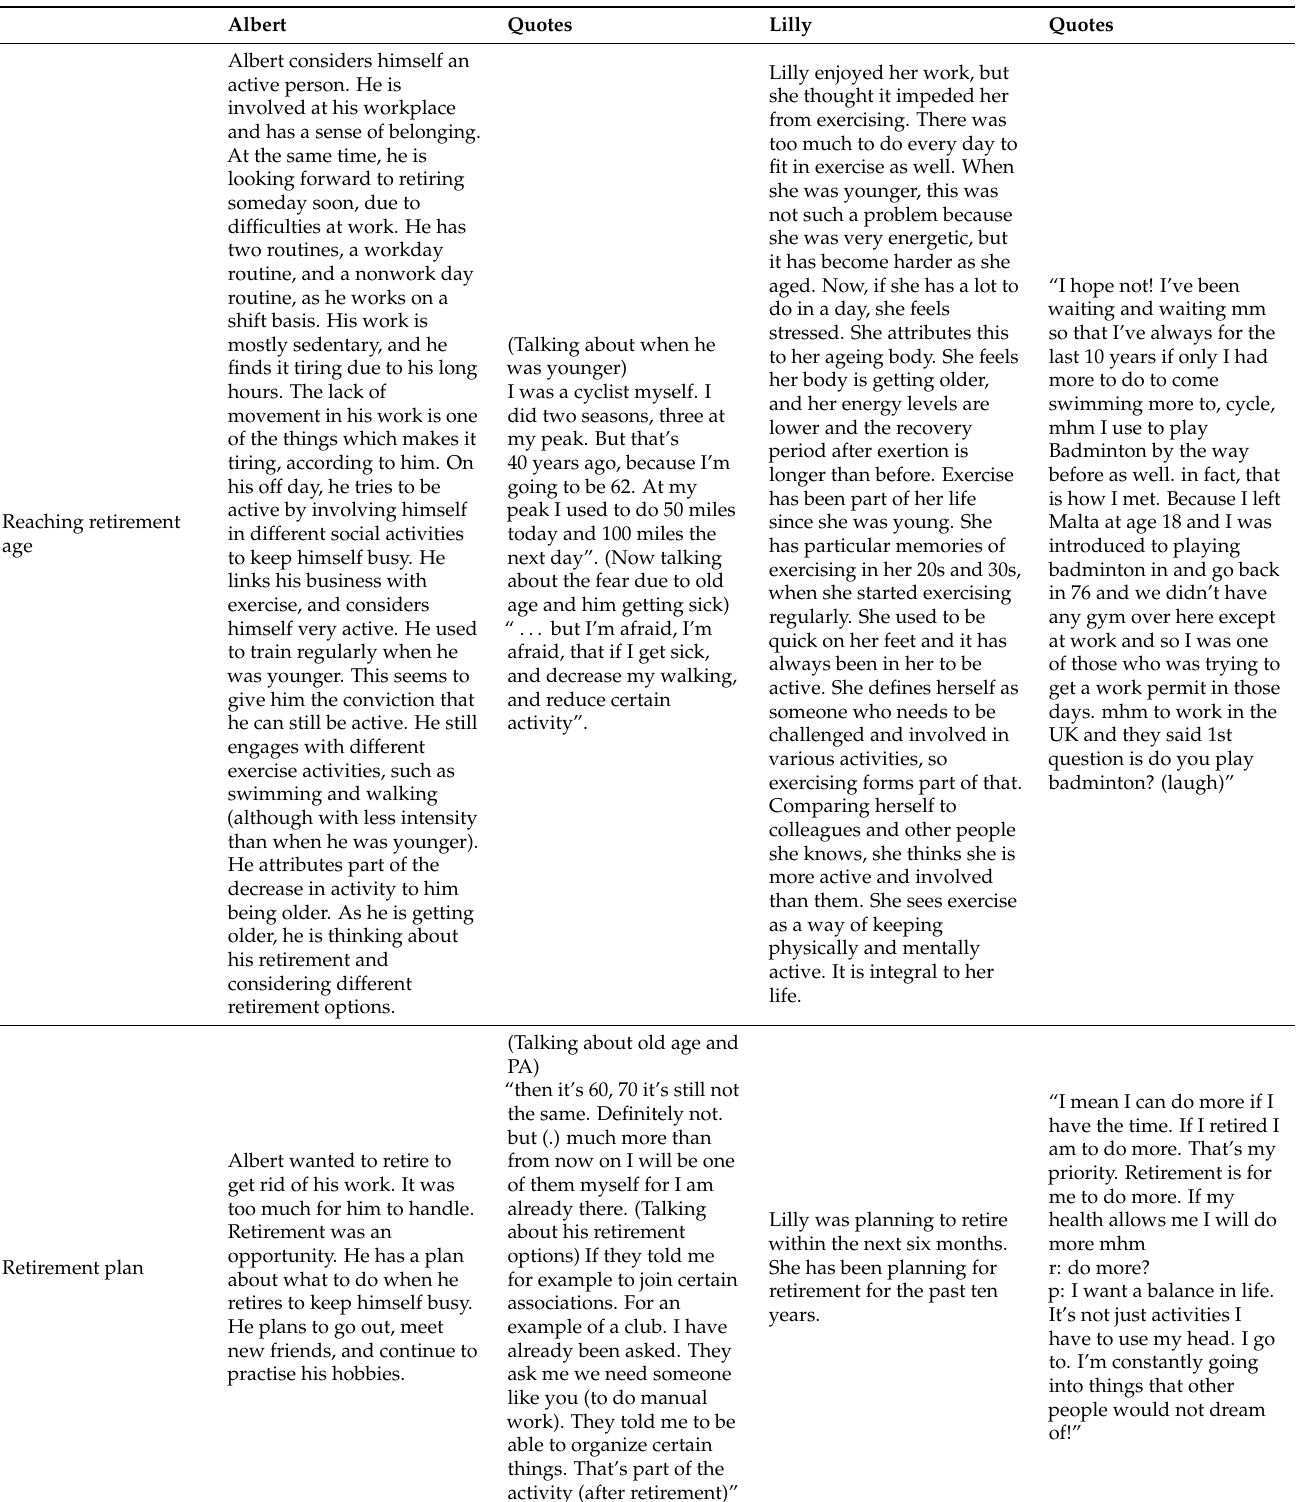
Table 7. Participants’ stories using structural narrative